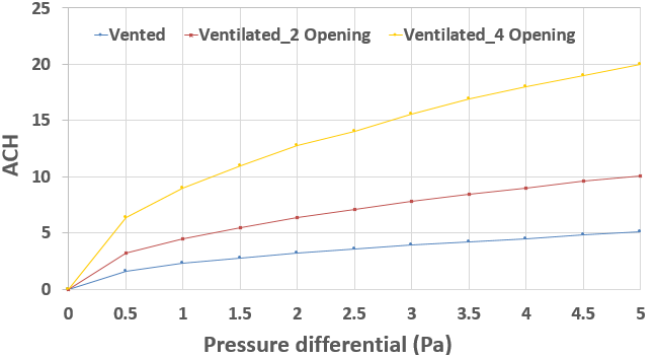
Figure 6. Cladding ventilation rate as a function of pressure differential for a brick wall.